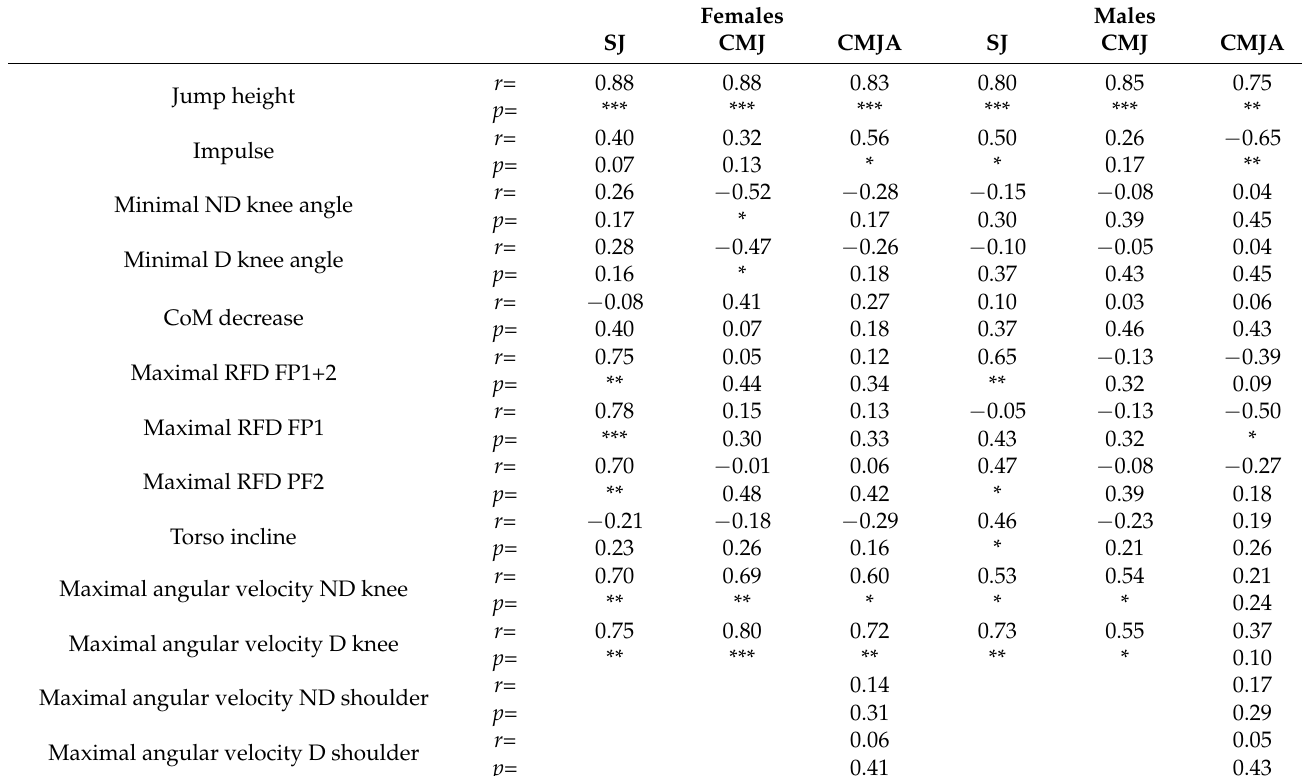
Figure 3. Each participant’s mean jump heights of all jump types and correlation between VSJ and general jump types in females and males. Table 1. Correlation results between volleyball spike jump height and variables during general jump types in females and